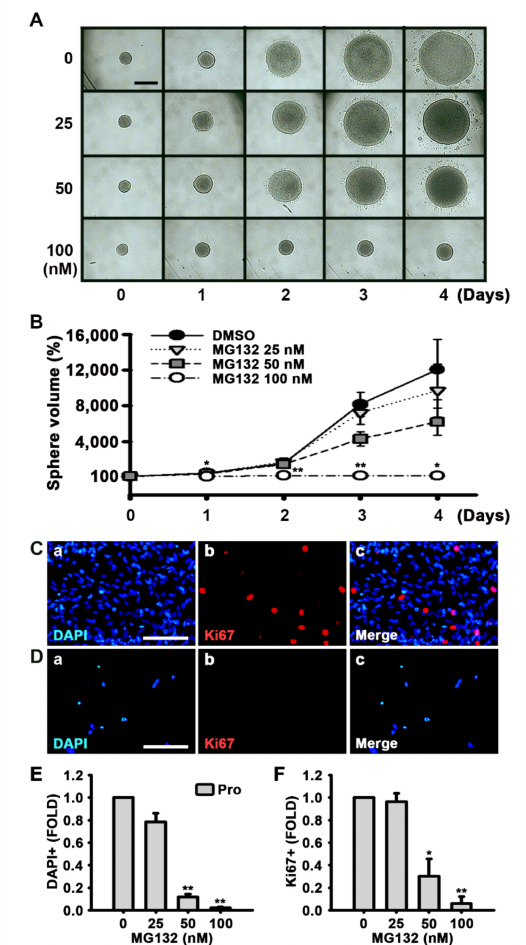
Figure 3. MG132 inhibits NSC proliferation in the presence of growth factors. ( A ) Digital images of neurospheres treated with either DMSO or 25, 50, and 100 nM MG132 for 4 days in the presence of EGF and FGF2. Scale bar = 500 µ m. ( B ) Neurosphere volume was calculated by measuring the diameter of individual neurospheres treated with DMSO or MG132. Data are expressed as mean ± SEM ( n = 3). ( C , D ) Representative immunofluorescence images of NSCs proliferated for 48 h. DAPI-positive nuclei ( a , blue), Ki67-positive cells ( b , red), and merged image ( c ). NSCs proliferated for 48 h with ( C ) DMSO or ( D ) 100 nM MG132 in the presence of EGF and FGF2 were immunostained with anti-Ki67 antibody. Scale bar = 100 µ m. ( E , F ) Quantification of ( E ) nuclei and ( F ) Ki67-positive cells. Data are presented as mean ± SEM ( n = 3). * p < 0.05, and ** p < 0.01, (Student’s t -test).